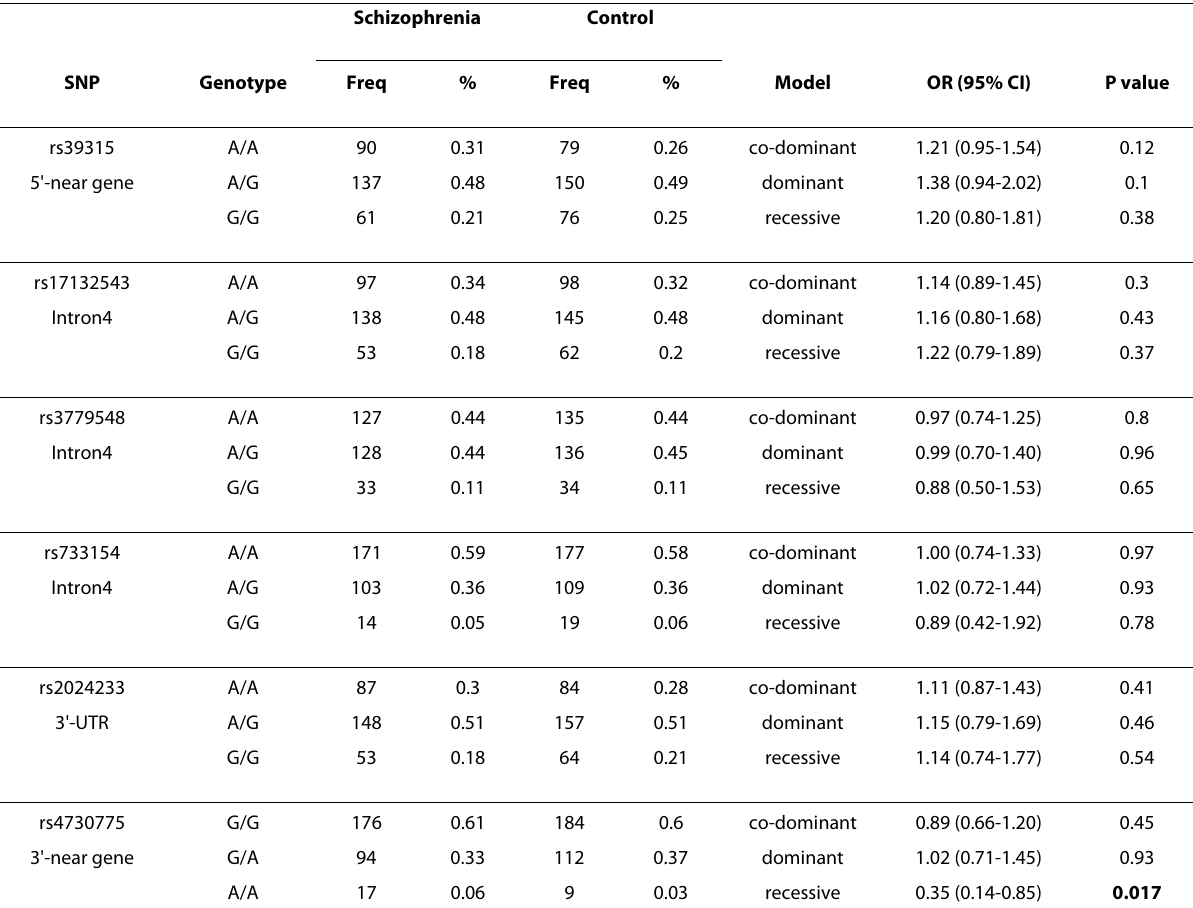
Table 1: WNT2 SNPs genotype and allele frequencies in schizophrenia patients and healthy controls